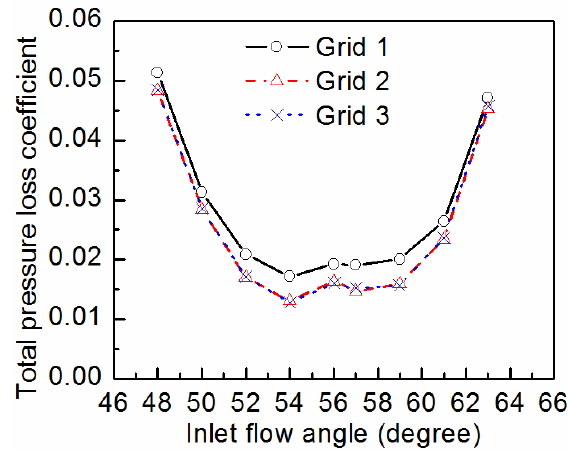
Figure 7. Loss buckets calculated for different